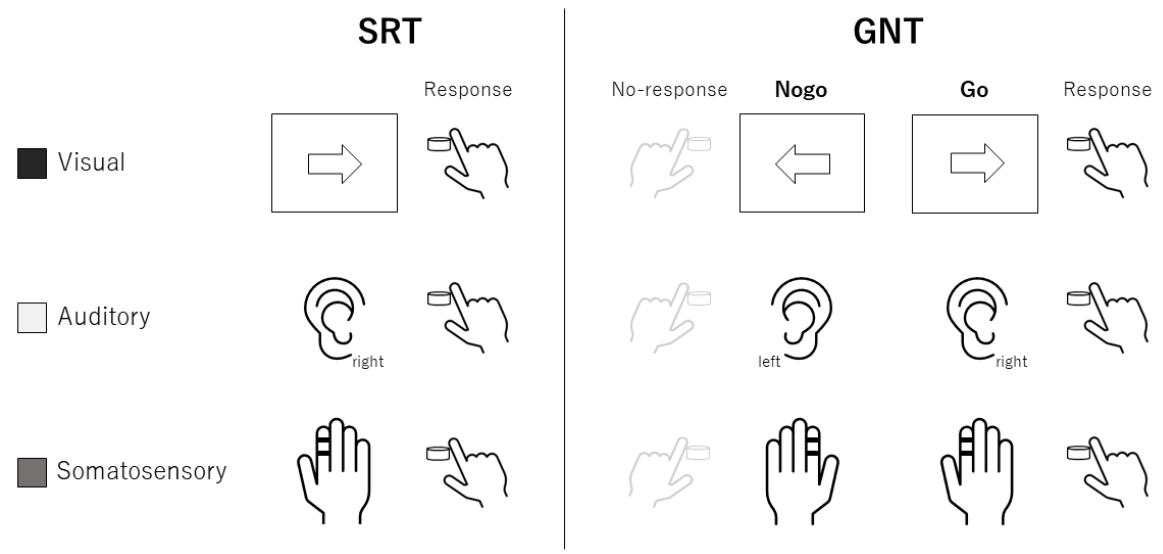
Figure 2. SRT and GNT paradigms in each modality. See text for details. SRT, simple reaction task; GNT, Go/No-go